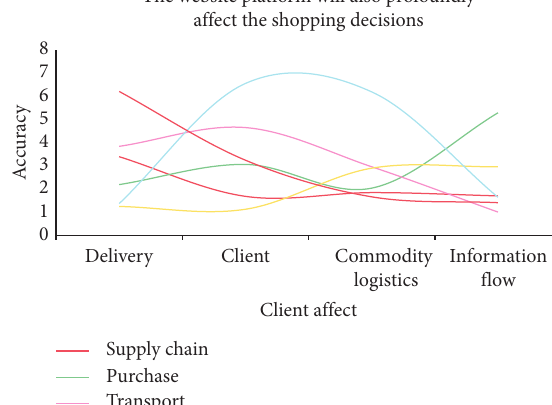
Figure 4: The website platform will also profoundly affect the shopping decisions.